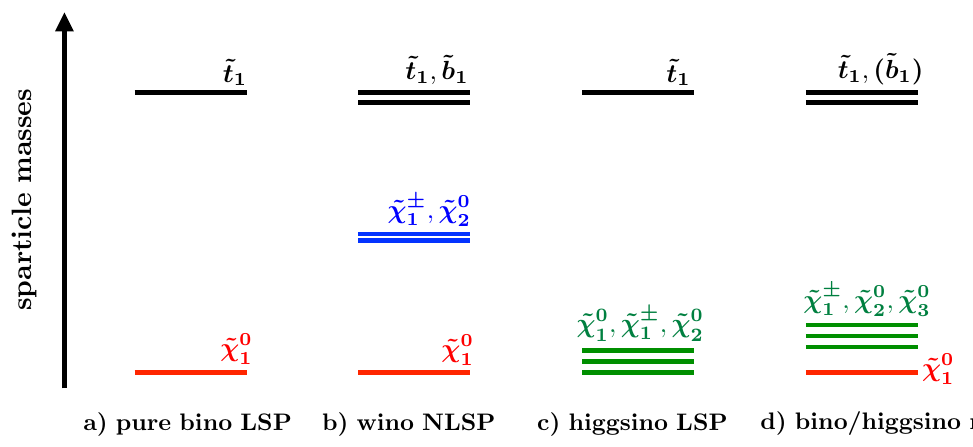
Figure 2 . Illustration of the sparticle mass spectrum for various LSP scenarios: a) pure bino LSP, b) wino NLSP, c) higgsino LSP, and d) bino/higgsino mixed LSP. The ~ t lines, decay into various electroweakino states: the bino state (red lines), wino state (blue lines), or higgsino state (green lines), possibly with the subsequent decay into the LSP. The light sbottom (~ b ) is considered only for pMSSM models with m q 3 L < m tR 1